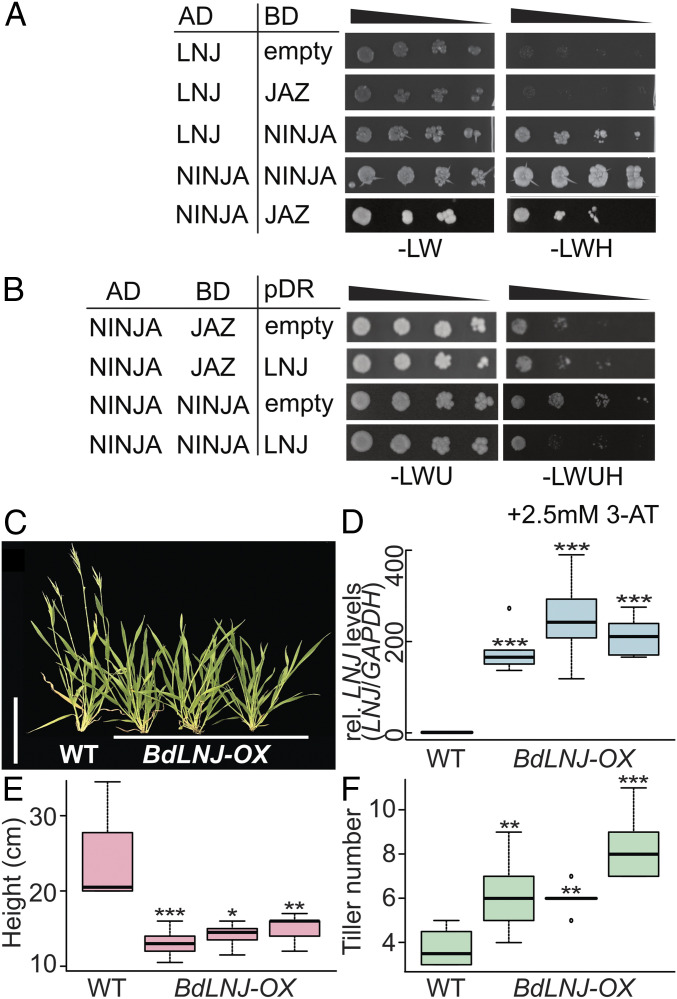
LNJ interacts with NINJA and ectopic expression alters the shoot architecture of Brachypodium plants. (A) Yeast-two-hybrid interaction of LNJ (BRADI1g69970) fused to the Gal4 AD and the Gal4 BD and fusions of BD to JAZ (BRADI1g21490) and NINJA (BRADI2g11790). LNJ interacts with NINJA as indicated by growth on selective medium (−LWH). No interaction was observed between LNJ and JAZ but NINJA and JAZ interact and NINIJA can also homodimerize as indicated by growth on selective medium of yeast expressing both AD-NINJA and BD-NINJA or BD-JAZ. (B) Yeast-three-hybrid interaction assay. Yeast expressing AD fusions to NINJA and BD fusions to JAZ or NINJA were transformed with either pDR-empty or pDR-LNJ. NINJA/JAZ and NINJA/NINJA dimerization was observed on quadruple dropout medium in the presence of the empty vector, in the presence of LNJ; NINJA/JAZ heterodimerization remained unaffected but homodimerization of NINJA was weakened as indicated by a reduced ability to grow on the selective medium. (C) Picture of 4-wk-old plants of the wild-type Bd21-3 and three independent BdLNJ-OX lines grown under long day (LD) photoperiod (22/18 °C, 16 h light/8 h dark). (Scale bar, 10 cm.) (D) Relative expression levels of BdLNJ mRNA in wild-type and independent T3 transgenic plants determined by qRT-PCR. Expression levels, determined as relative quantities and normalized against Brachypodium GAPDH gene, are depicted as box plots, n = 3. (E) Quantification of plant height depicted as box plots in wild-type and three independent BdLNJ-OX lines grown under LD photoperiod. (F) Quantification of tiller number depicted as box plots in wild-type and three independent BdLNJ-OX lines grown under LD photoperiod. *P < 0.05, **P < 0.005, ***P < 0.0005 determined by Student’s t test. n = 15 to 20.